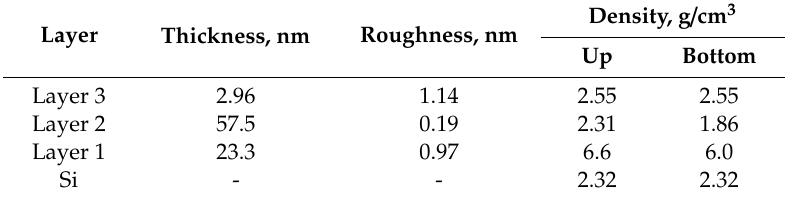
Table 4. Results of X-ray reflectometry (XRR) curves modeling and fitting for the LNO-M sample.